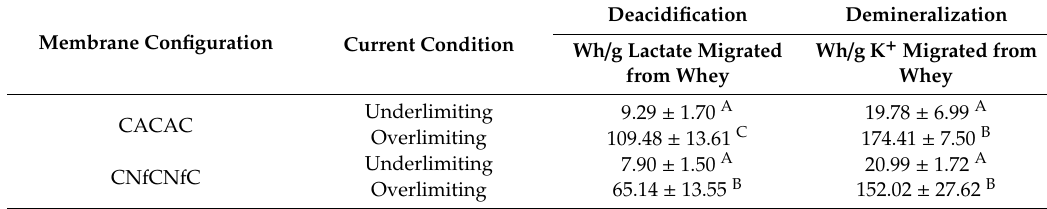
Table 5. Energy consumption during ED for all configurations and current conditions